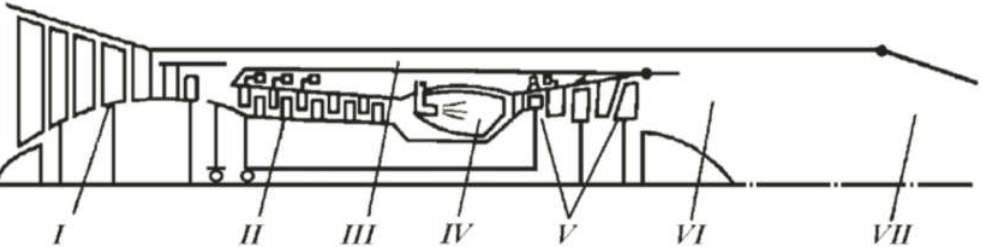
Figure 1. Generalized schematic of the twin-shaft aircraft engine [19]: I: fan (LP compressor); II: HP compressor; III: bypass duct; IV: main combustion chamber; V: HP and LP turbines; VI: mixing chamber; VII: nozzle.